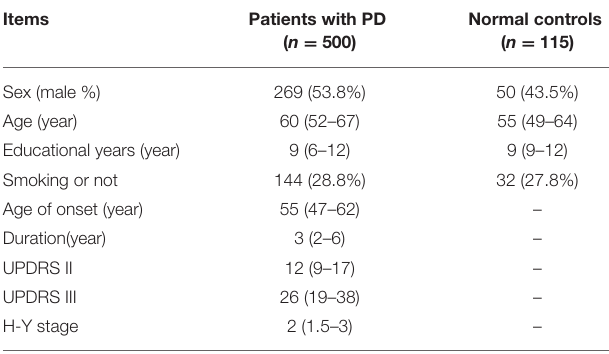
TABLE 1 | Basic information and motor features in patients with Parkinson’s disease (PD) and controls.